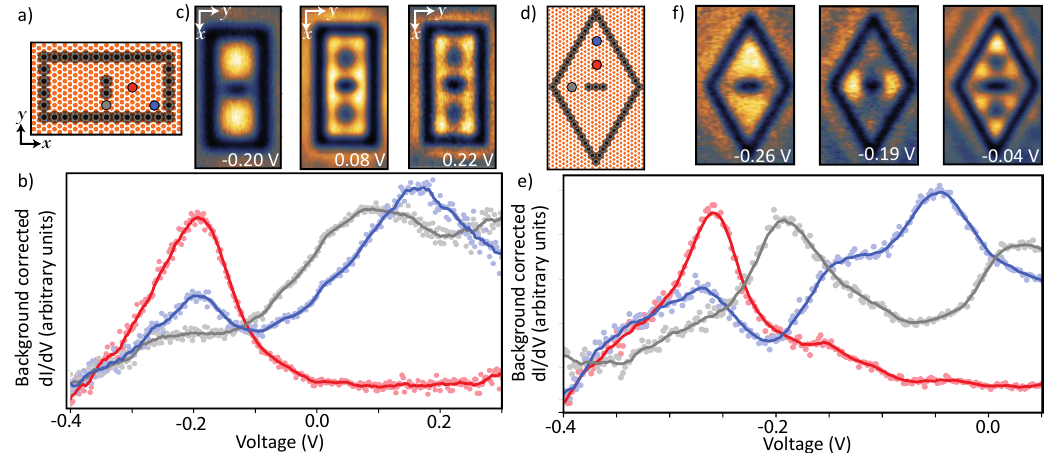
Figure 8: (a) Coupled rectangular corrals with a barrier that largely inhibits the coupling of s and p -type states, while coupling of p -like states is clearly observed. x y x and y directions are specified in the figure. (b) Differential conductance spectra taken at the positions indicated in (a). (c) Differential conductance maps taken at the indicated energies. (d-f) same as (a-c) but for coupled triangular